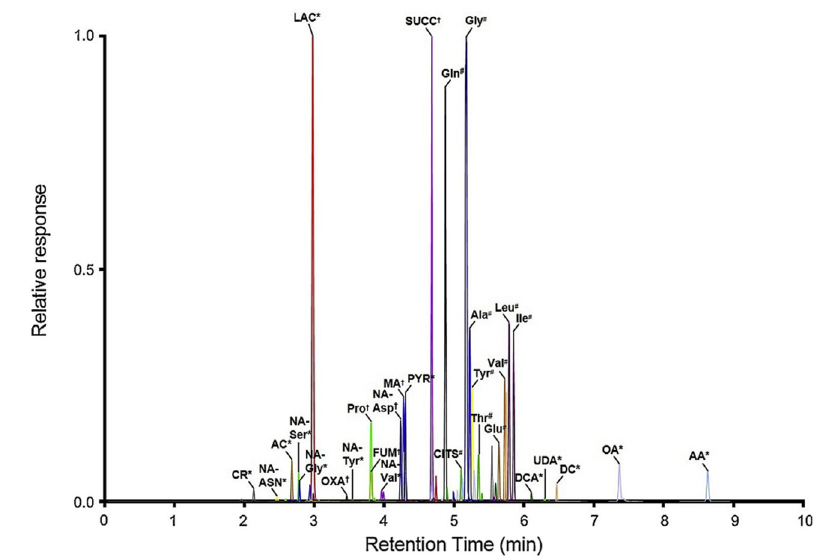
Figure 8. LC–MS/MS chromatogram of 64 metabolites after dimethylaminophenacyl bromide (DmPABr) derivatization in SUIT-2 cells. DmPA labeling patterns are also included (* = labeled once; † = labeled twice; # = labeled thrice). [57]—Reproduced with the permission of Elsevier. Table 3. Analytical methods for amino acid metabolites in biological samples.